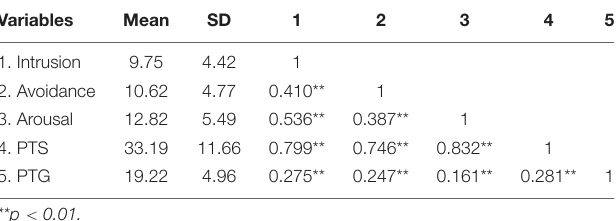
TABLE 1 | Mean, standard deviation (SD), and correlation among all the variables of the study.